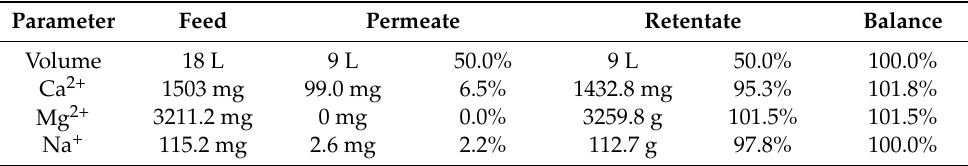
Table 5. Mass balance of the RO process for the SWC-2540 membrane.